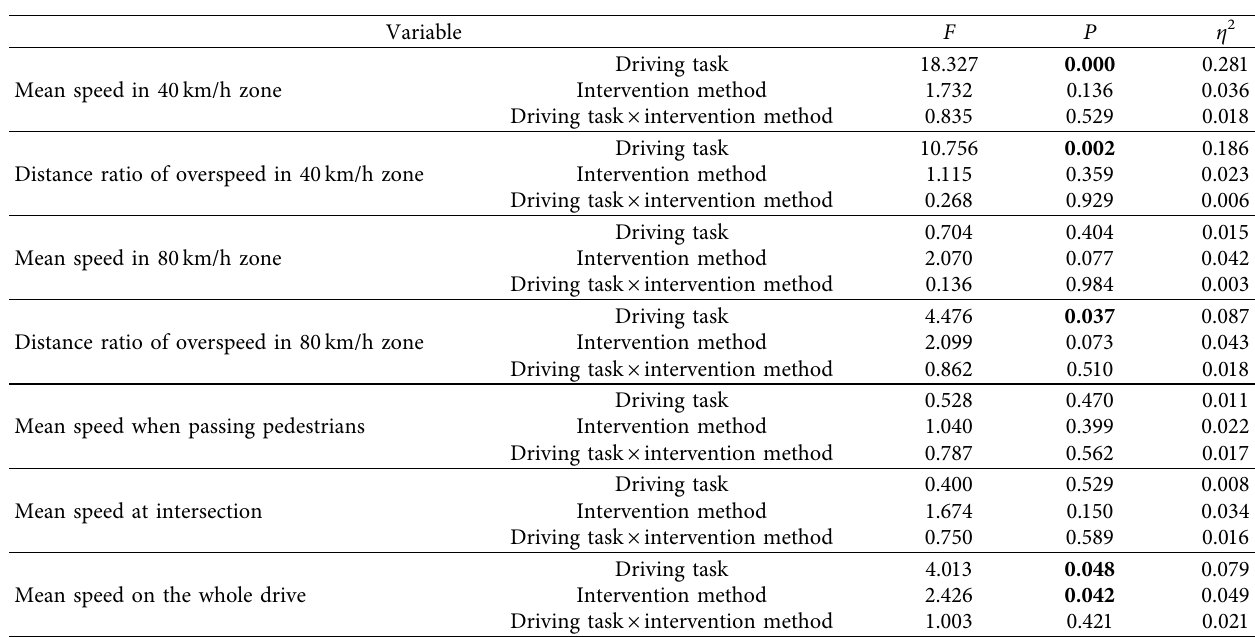
Table 5: Te ANOVA